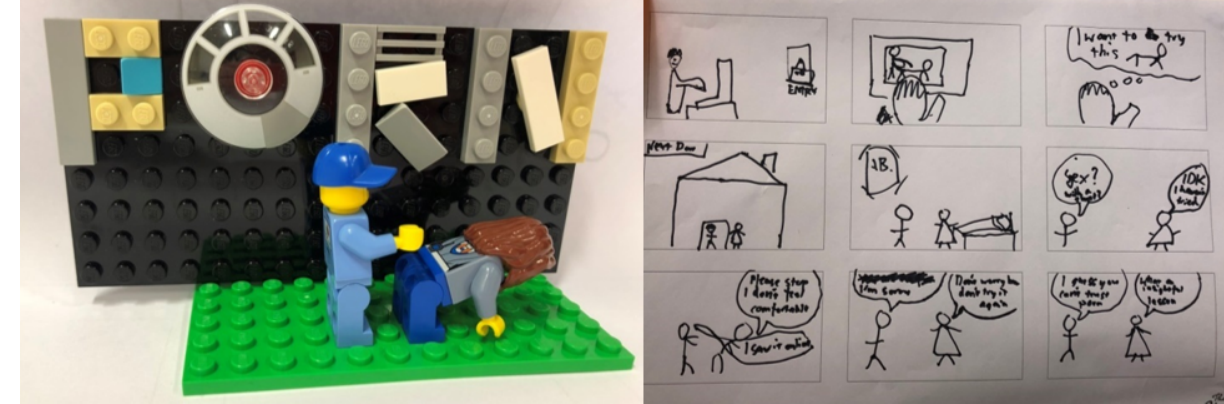
Figure 3. Stop motion movie scene and storyboard activity